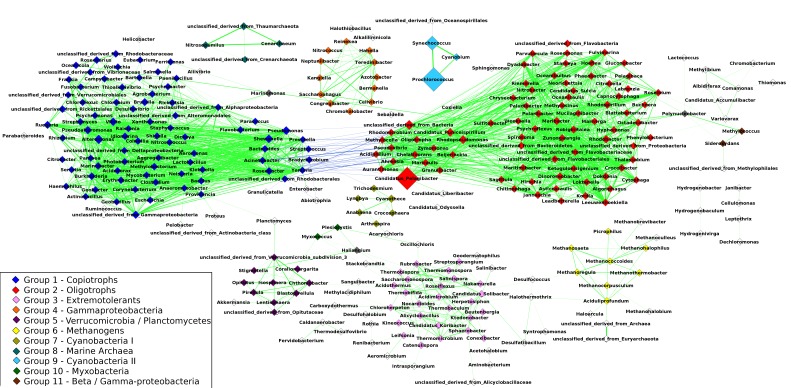
Correlations network: the 1,906 edges linking 297 nodes represent significant correlations between the relative abundances of the connected taxa.Positive correlations are showcased in green while negative ones are in blue. The width of the lines is proportional to the module of Spearman’s R of each correlation. Node size represents the average abundance of the taxa across the 180 metagenomes. Nodes are color-coded according to the group to which they were assigned through the Clique Percolation Method. Nodes not assigned to any group are colored in white and nodes assigned to more than a single group (Polynucleobacter, Marinomonas and Haliangium) are colored in gray. For clarity, members of Groups 1 and 2 that are connected by negative correlations are displayed separately from the remaining taxa of their respective groups. Pelagibacter, Prochlorococcus and Synechococcus showed the highest average abundance. Positive correlations dominate the network. The majority of negative correlations were observed between members of groups 1 and 2, between classical examples of oligotrophs and copiotrophs (e.g., Pelagibacter/Yersinia). Groups 8 and 9 are isolated, while the remaining groups have at least one edge linking them to other nodes in the network. Strong positive correlations were observed between the members of groups 8 and 9 (e.g., Synechococcus/Prochlorococcus and Cenaracheum/Nitrosopumilus).